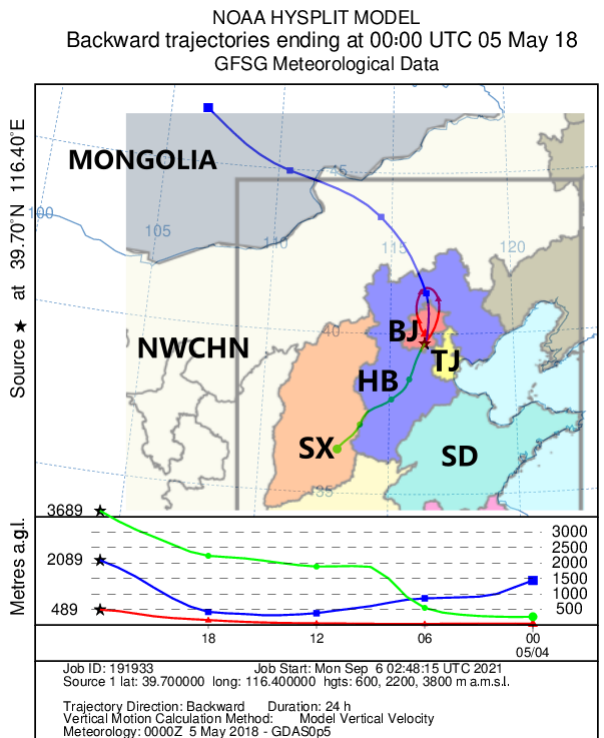
Figure 7. Backward trajectory (24h) of the air mass at 08:00BJT on 5